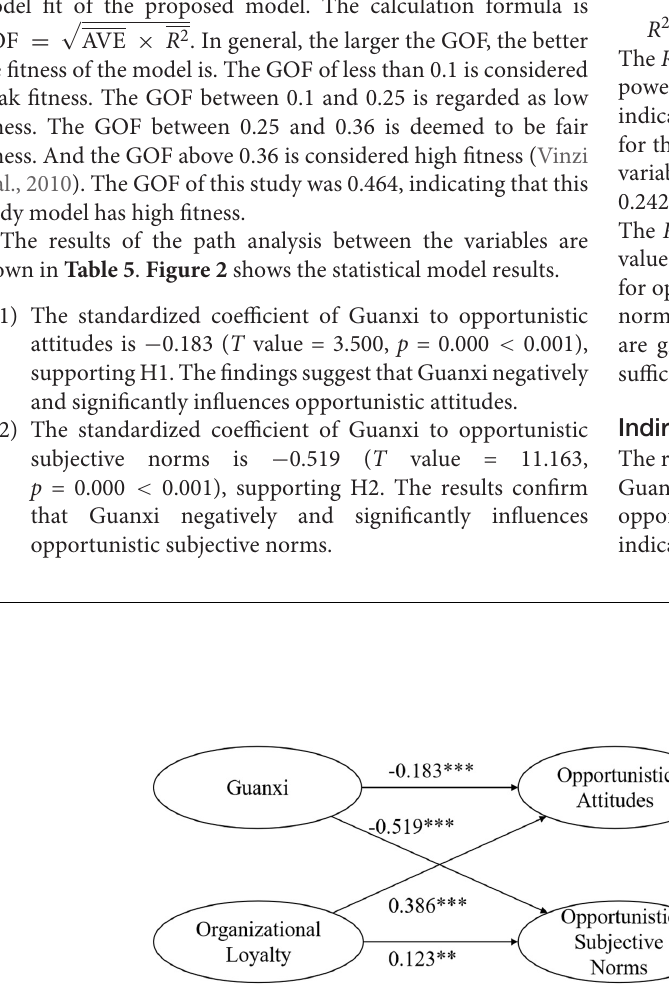
FIGURE 2 | Structural model, ∗ p < 0.05, ∗∗ p < 0.01, ∗∗∗ p <